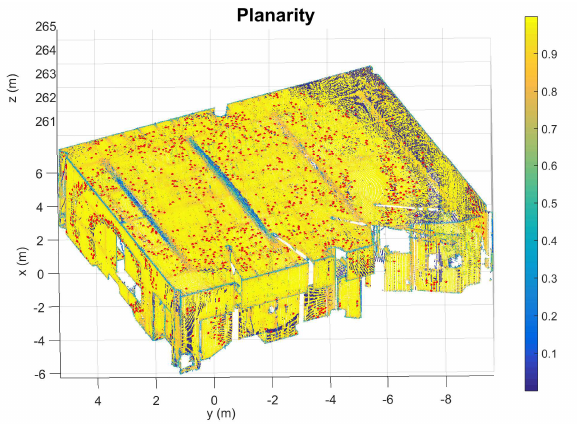
Figure 7. Classroom point cloud keypoints (red) from the pla- narity values.